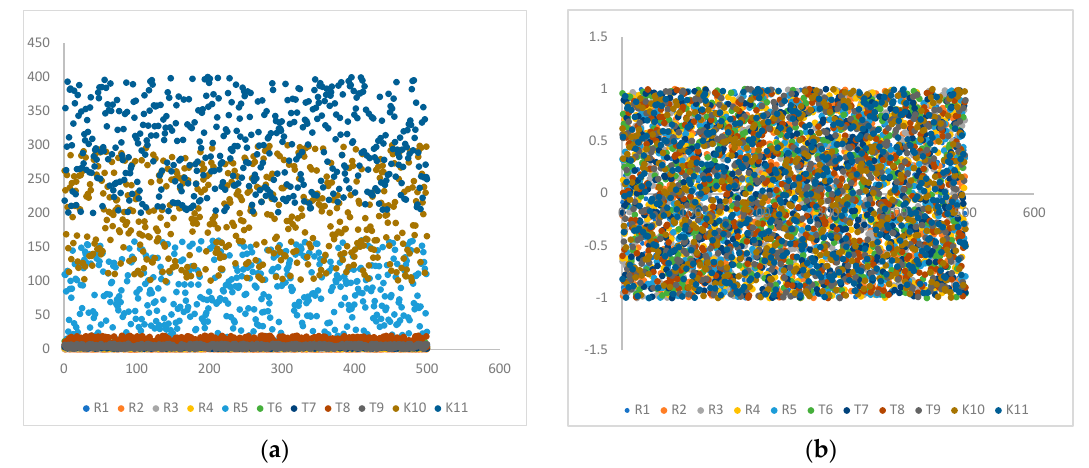
Figure 5. Comparison of the distribution of data before and after normalization ( a . Data before normalization; b . Data after normalization).